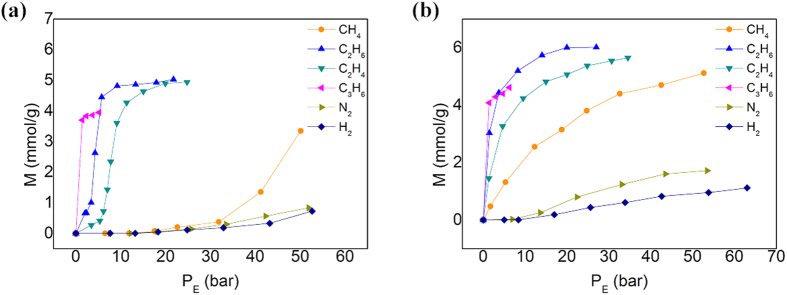
Adsorption isotherms of different gas species CH4, C2H6, C2H4, C3H6, N2, and H2on ZIF-8.(a) On ZIF-8 suspended in glycol with a mass fraction of 18.3%. (b) On ZIF-8 suspended in water with a mass fraction of 16.7% at 293.15 K.